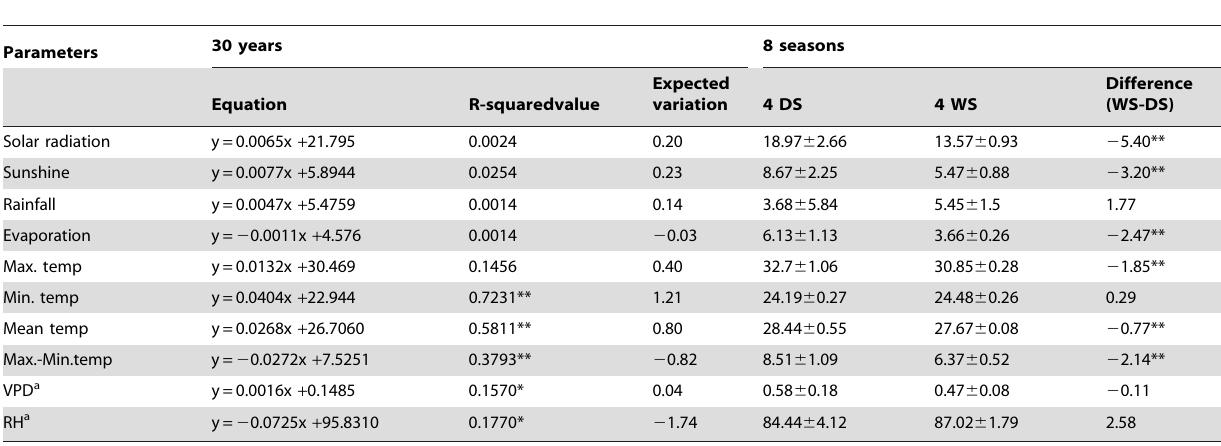
Table 1. Trends in climatic parameters from 1980 to 2009 and observed average data of 8 seasons.